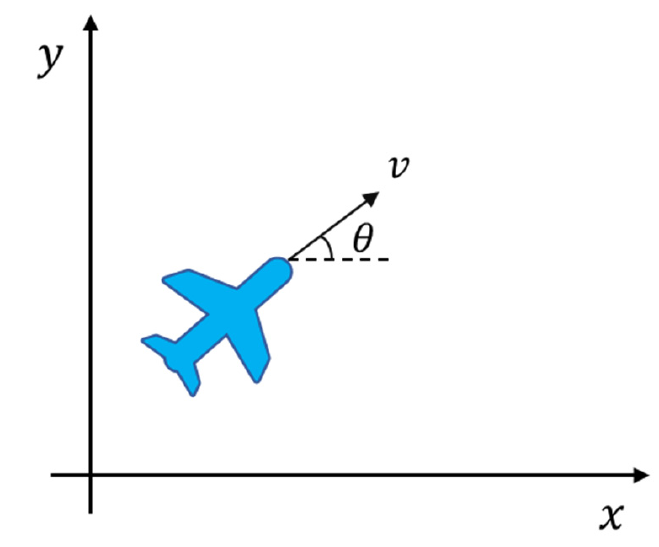
Figure 2. Schematic diagram of UAV movement.